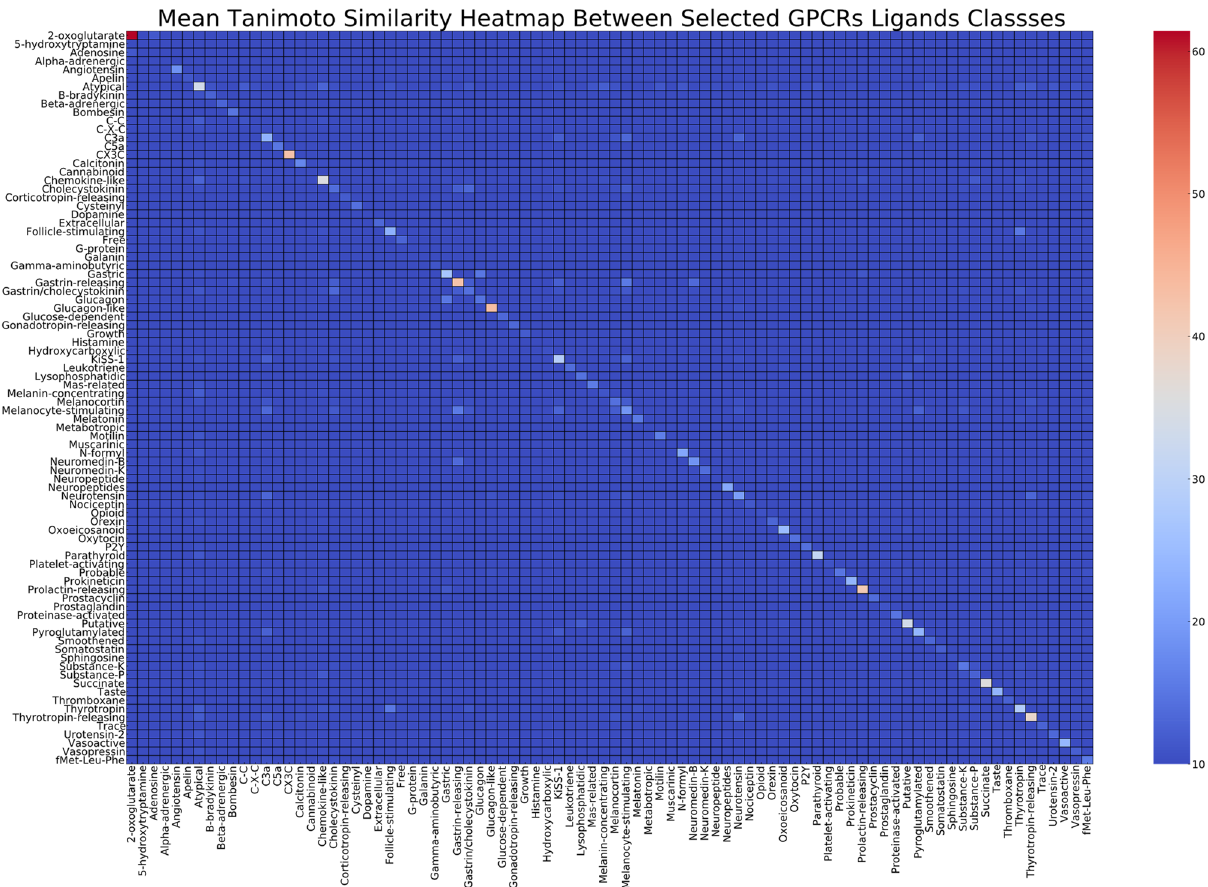
Figure 4. Mean Tanimoto similarity heatmap of the studied classes of GPCRs ligands. For the similarity analysis, ligands are represented through the ECFP6, radius 4